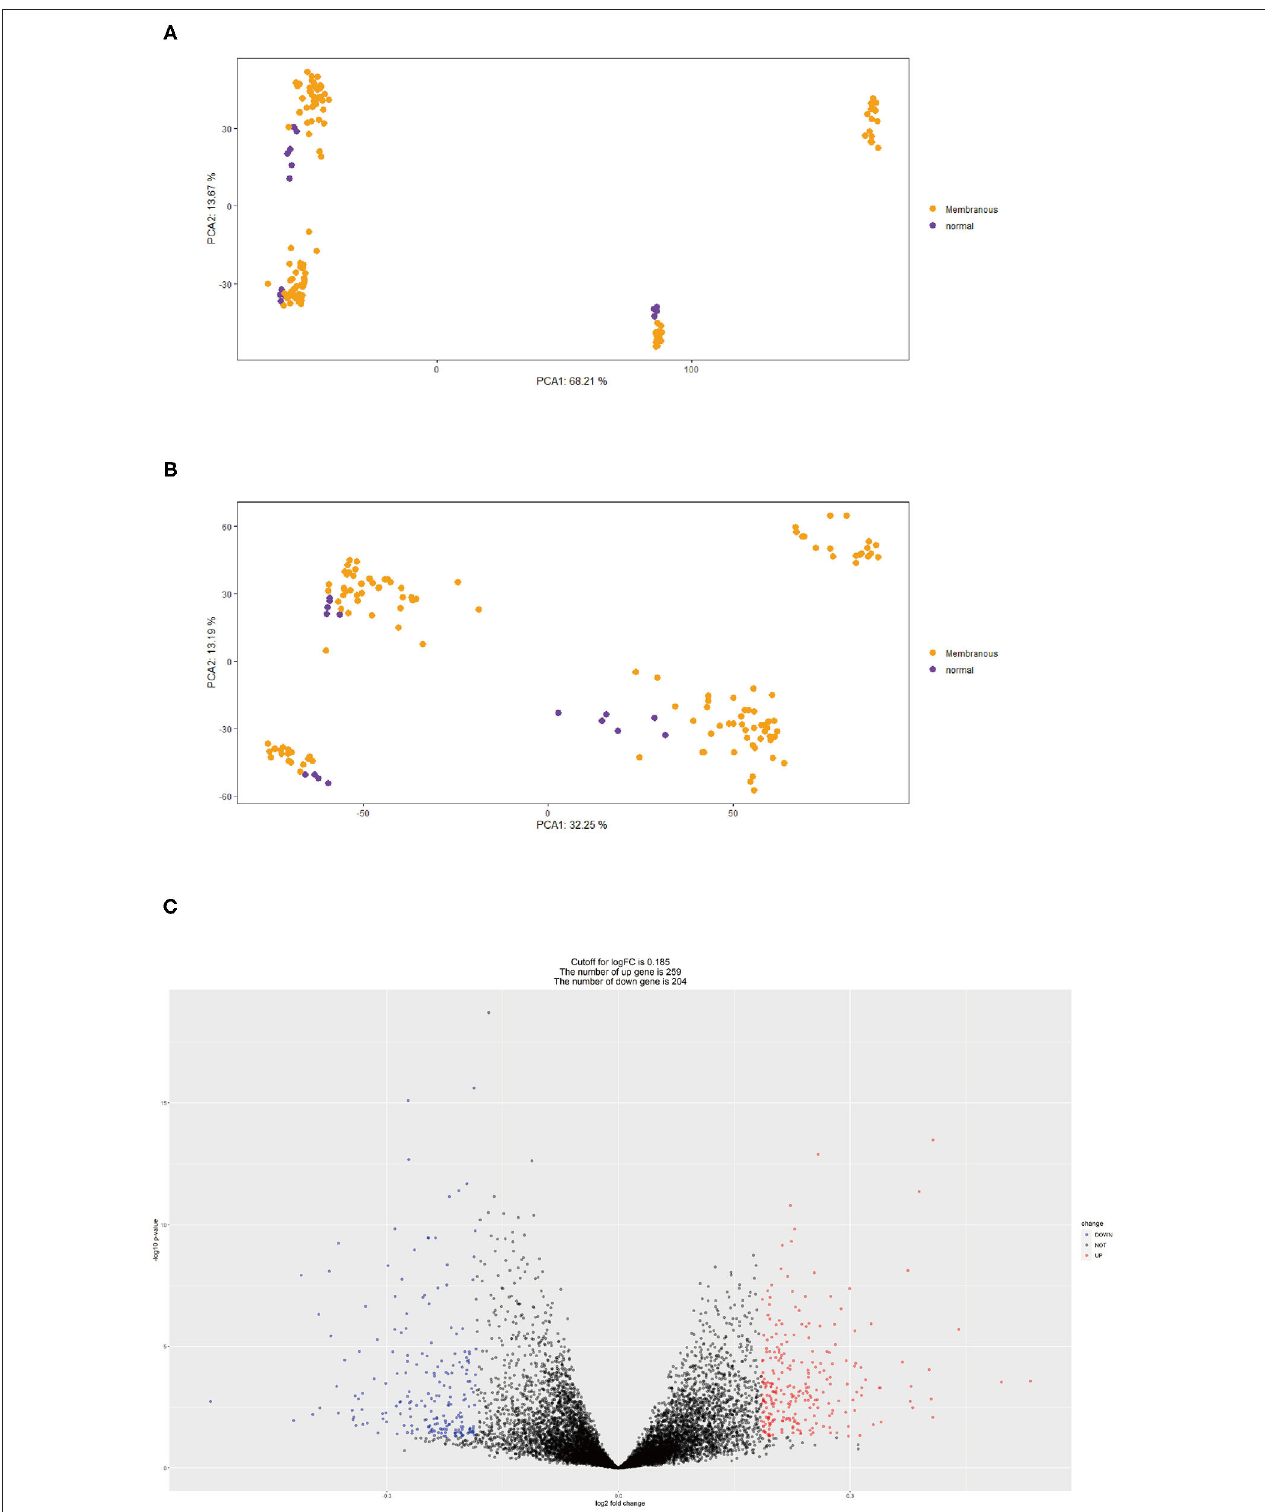
FIGURE 1 | (A) PCA clustering results of expression dataset before removing inter-batch difference: yellow dots represent MN samples and purple dots represent normal samples. (B) PCA clustering results of expression dataset after removing inter-batch difference, yellow dots represent MN samples and purple dots denote normal samples. (C) Volcano map for 463 DEGs, red represents up-regulated DEGs, blue represents down-regulated DEGs.